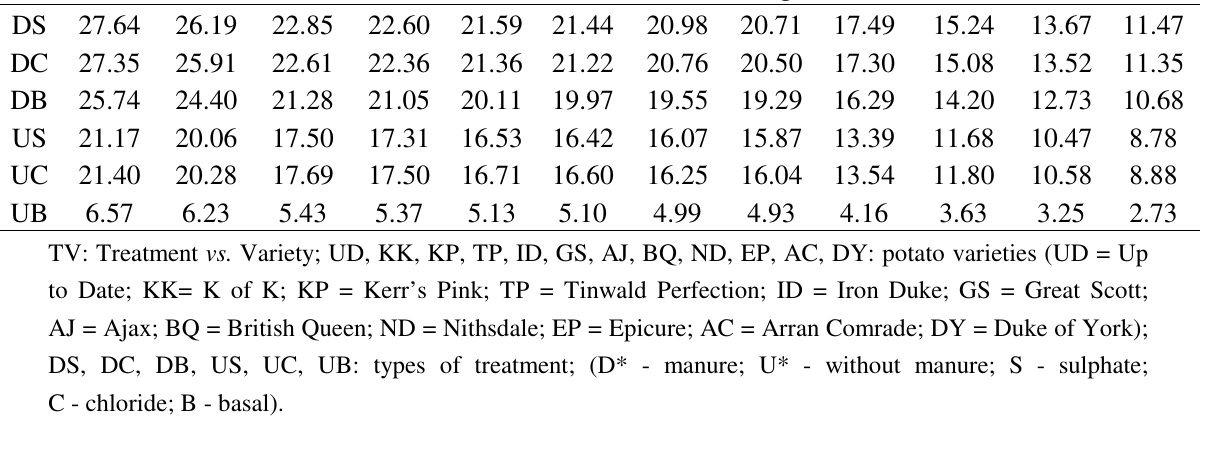
b ) calculated with Equation (11) for the i j 1 ≤ i ≤ 6; 1 ≤ j ≤ 12